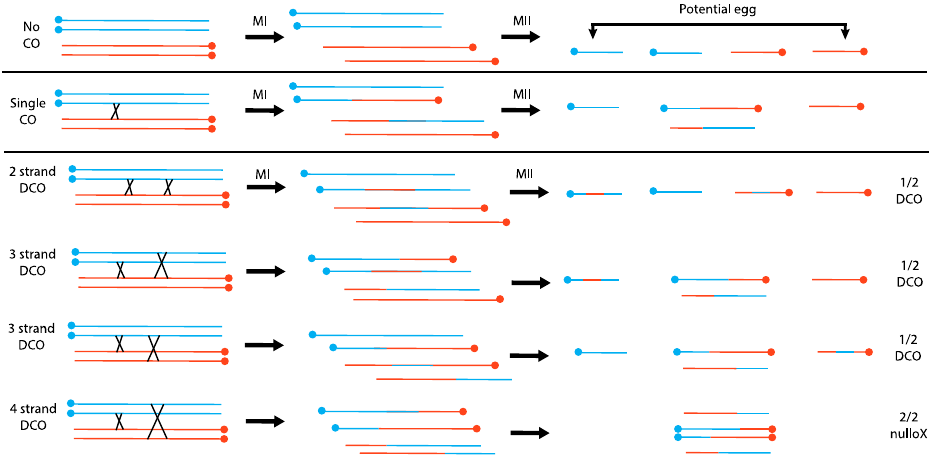
Figure 1. The consequences of crossing over between a normal X and an inverted X chromosome in Drosophila melanogaster . Individual lines are sister chromatids; blue and orange chromosomes are homologs; centromeres are solid circles. In females, the two meiotic divisions occur along a line, and one of the two terminal nuclei becomes the functional egg nucleus. When double crossovers occur, the proportion of embryos that receive a DCO X chromosome is 3 × ½ = 3/2; the proportion that receive no X is 1 × 2/2 = 2/2. Overall, the ratio of DCO:nullo embryos is 3/2:2/2, or 3:2, which will be the ratio seen among sons.